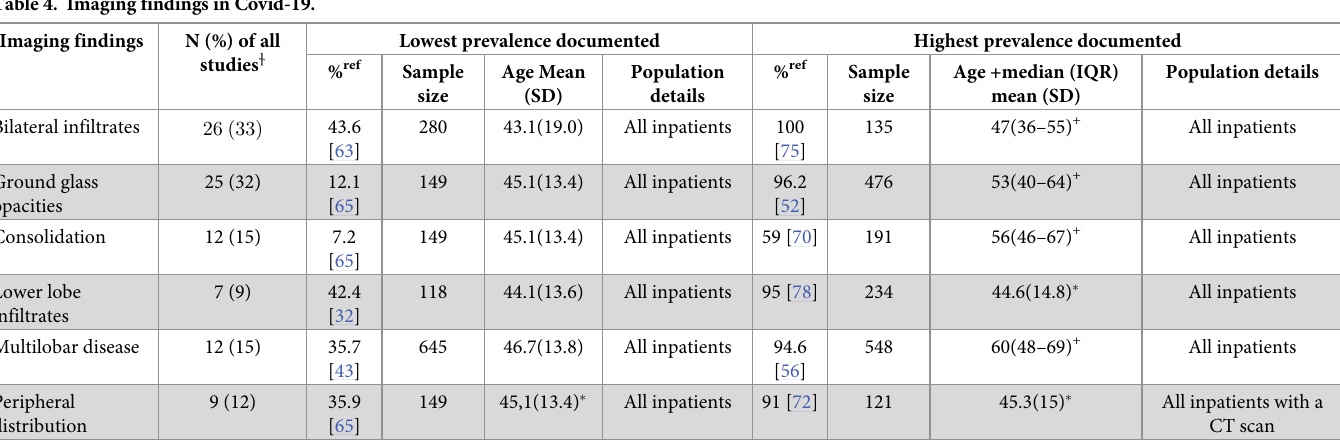
Table 4. Imaging findings in